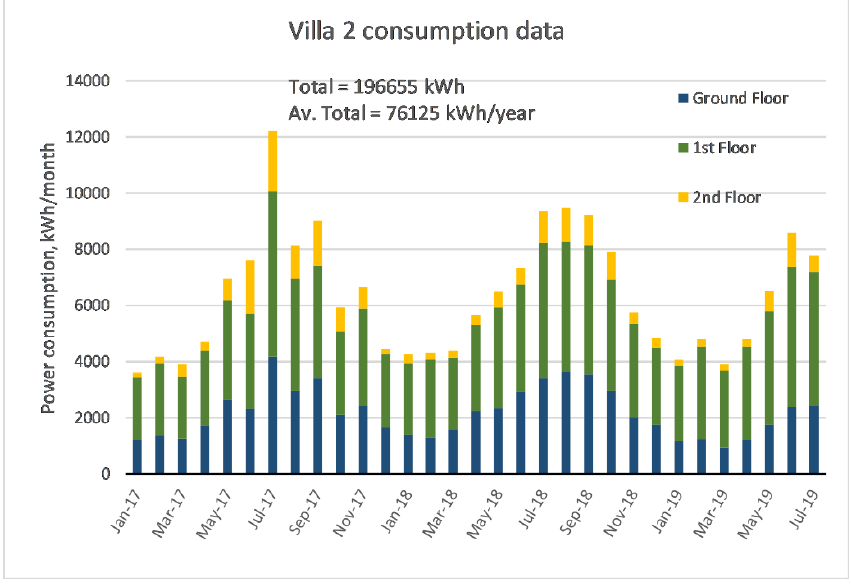
Figure 21. Consumption for Villa 2 for 31 months, from January 2017 until July 2019.